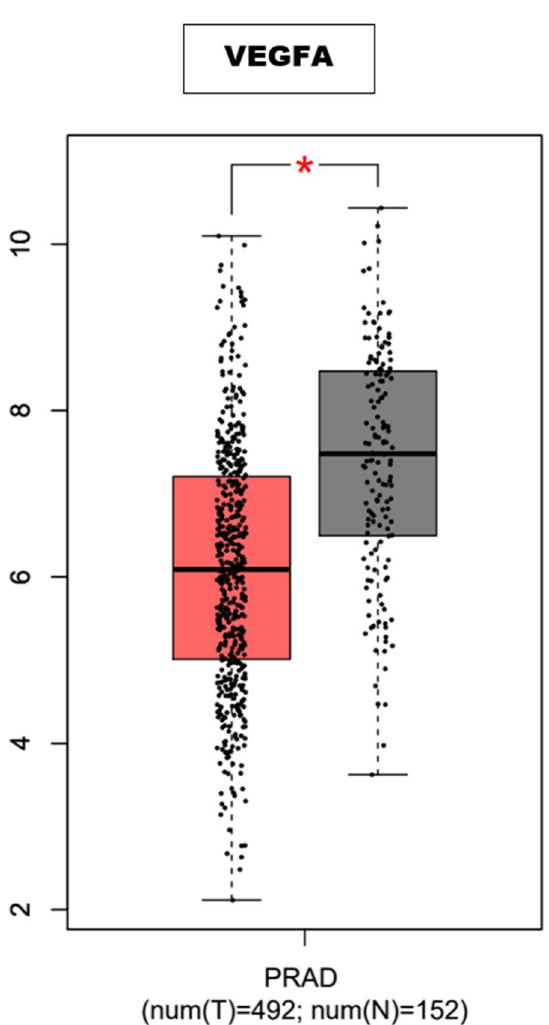
Fig. 6 Validation of VEGFA expression in PC cells and normal cells using the TCGA and GTEX data in the GEPIA server. The symbol symbolizes p < ∗